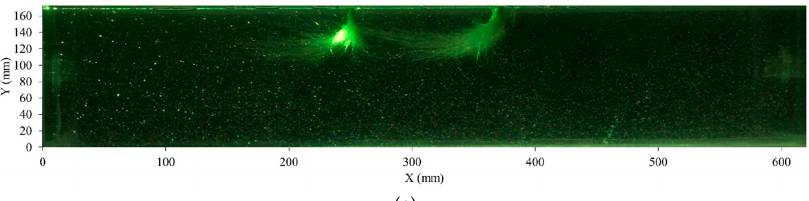
Figure 5. Plant roots under different flow rates. ( a ) 0 L/min; ( b ) 2 L/min; ( c ) 4 L/min; ( d ) 6 L/min; ( e ) 8 L/min.